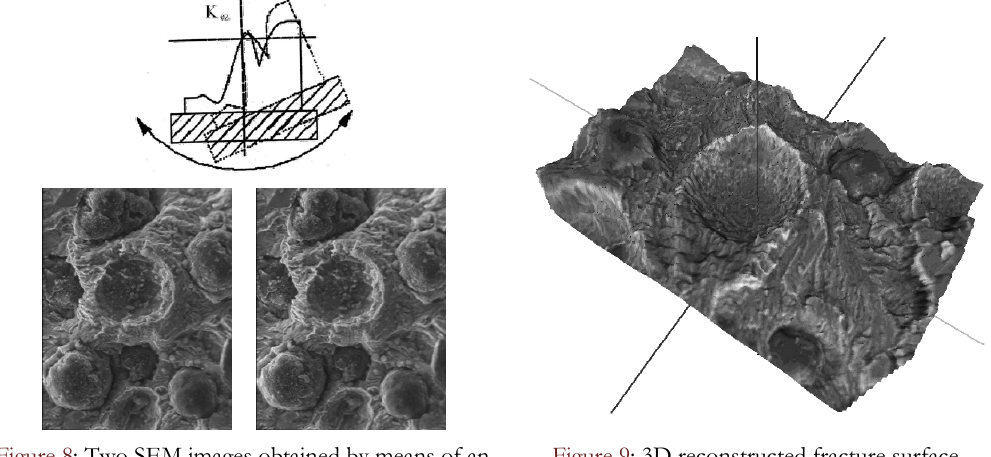
Figure 8: Two SEM images obtained by means of an eucentric tilting around the vertical.